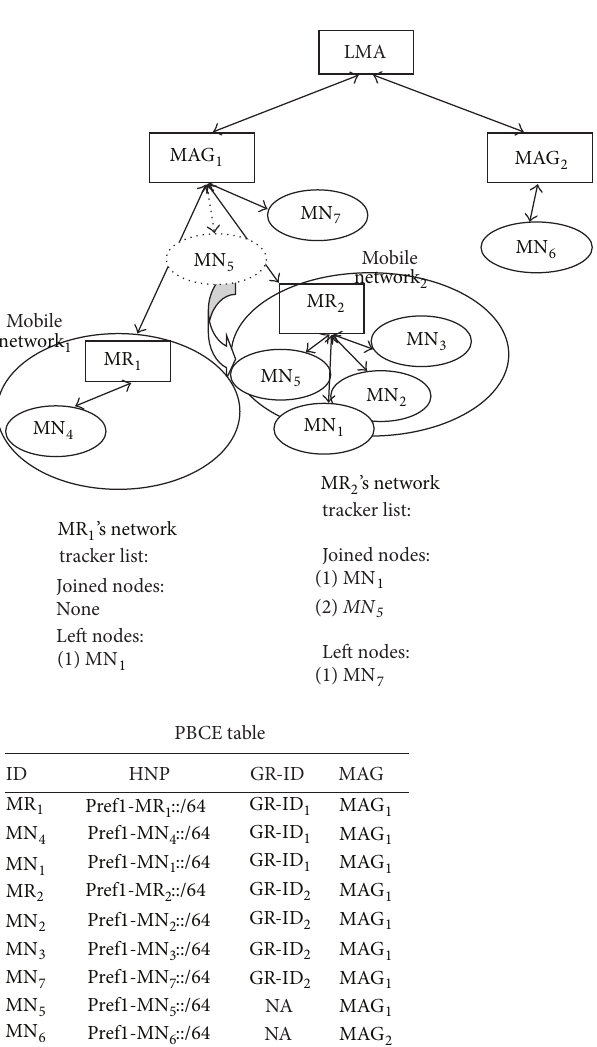
Figure 4: Intra-MAG movement: mobile node detaches from MAG and attaches to mobile